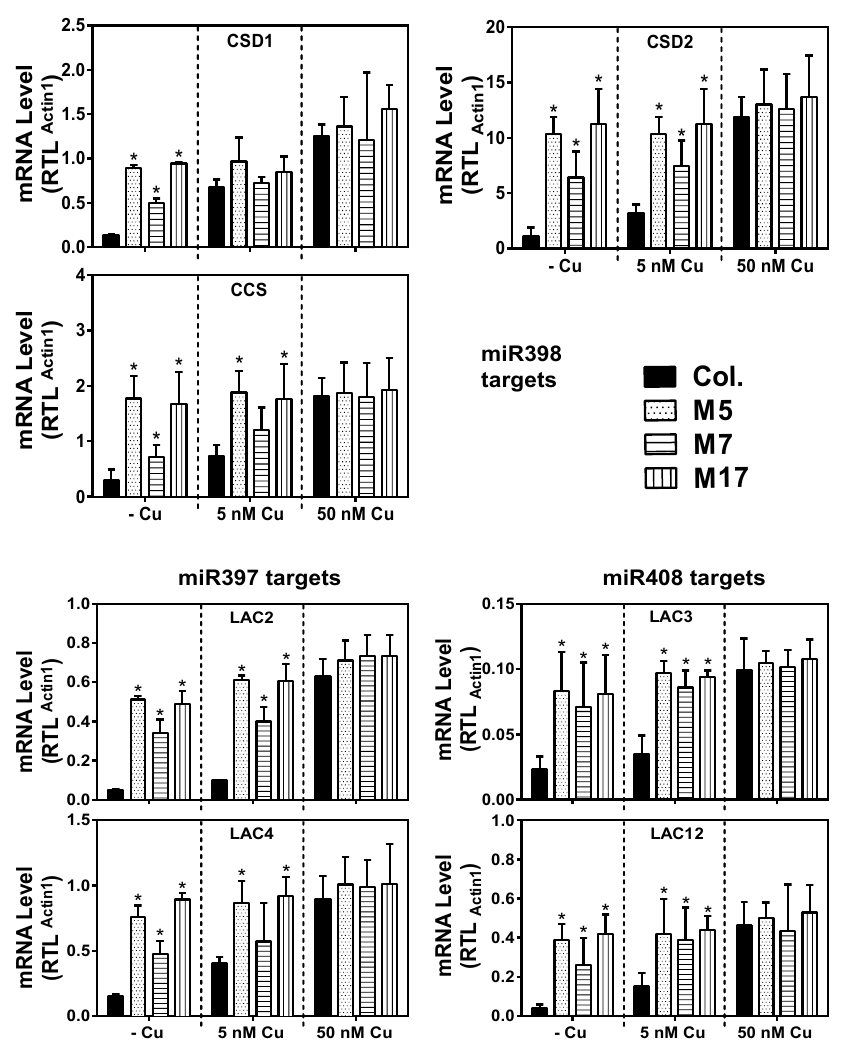
Figure 2. Expression analysis of selected Cu-microRNA target transcripts using qRT-PCR. mRNA-relative transcript levels (RTL) were normalized relative to actin 1 expression and given as averages ± SD ( n = 3). * indicate significant differences from the control ( p < 0.05, Student’s t -test).